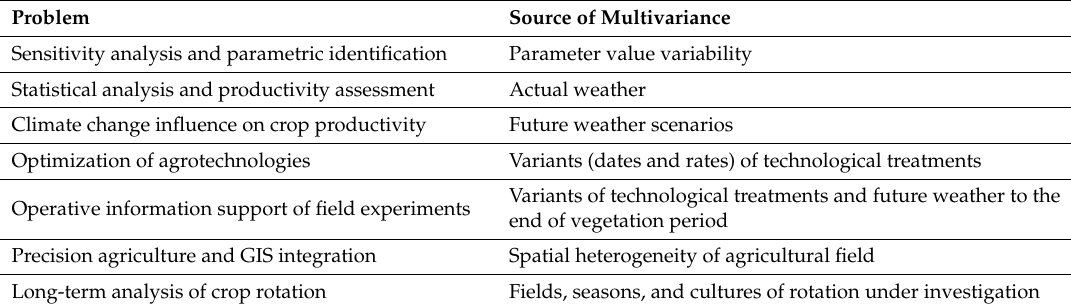
Table 2. Challenges for multivariant analysis.